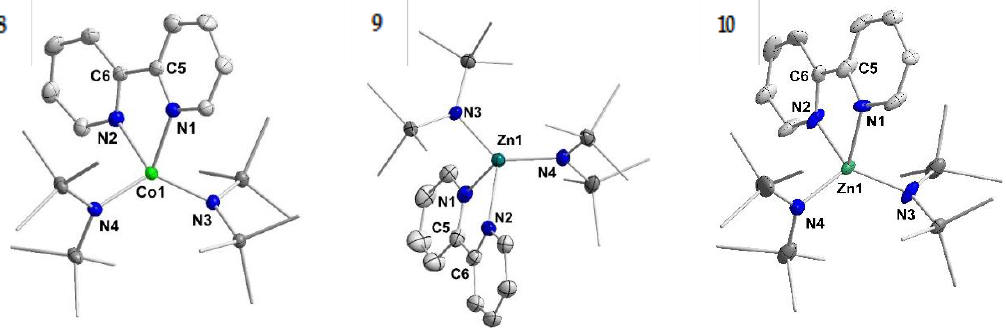
Figure 2. Molecular structure of compounds 8 – 10 . H atoms are omitted for clarity and ellipsoids are shown at 50% probability. The K{18c6}-cation is not shown for 10 .